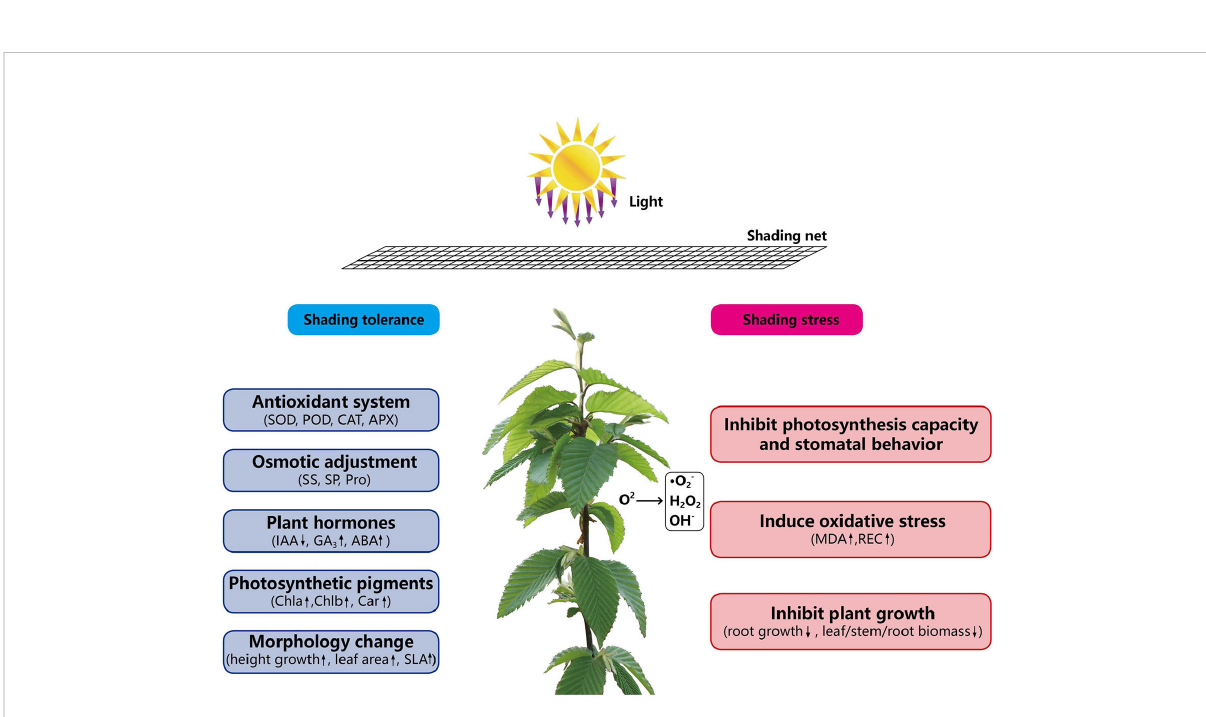
FIGURE 8 The mechanism of shading response of C. betulus